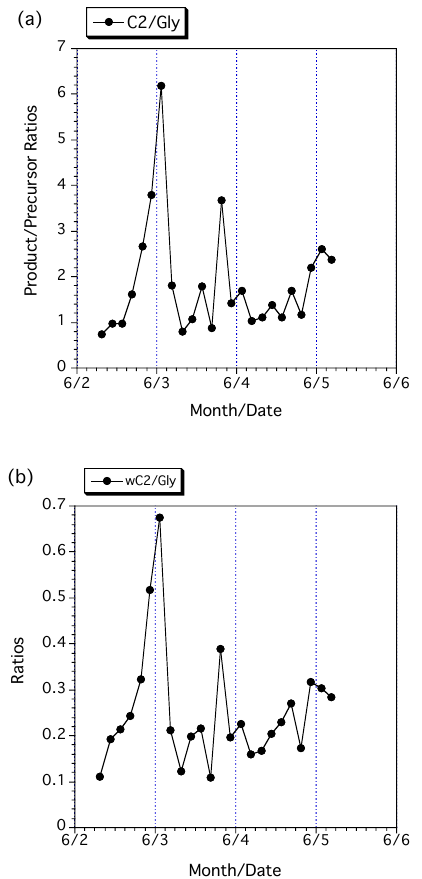
Fig. 12. Time-resolved variations in the concentration ratios of (a) particulate oxalic acid (C 2 ) /gaseous glyoxal (Gly) and (b) glyoxylic acid ( ω C 2 ) /gaseous Gly in the atmosphere of Mt. Tai. The data of organic acids in aerosols are from Kawamura et al.